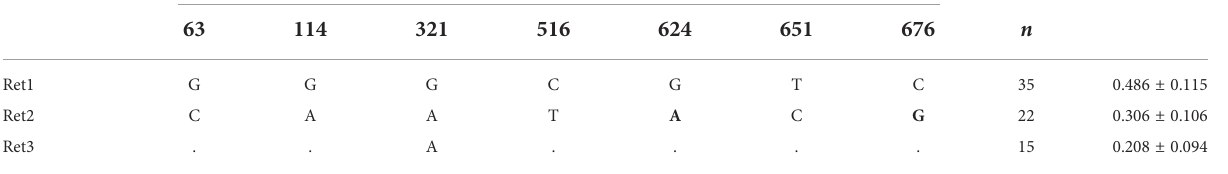
TABLE 1 PRNP SNPs in Eld ’ s deer haplotypes. Haplotype Nucleotide position in the coding region